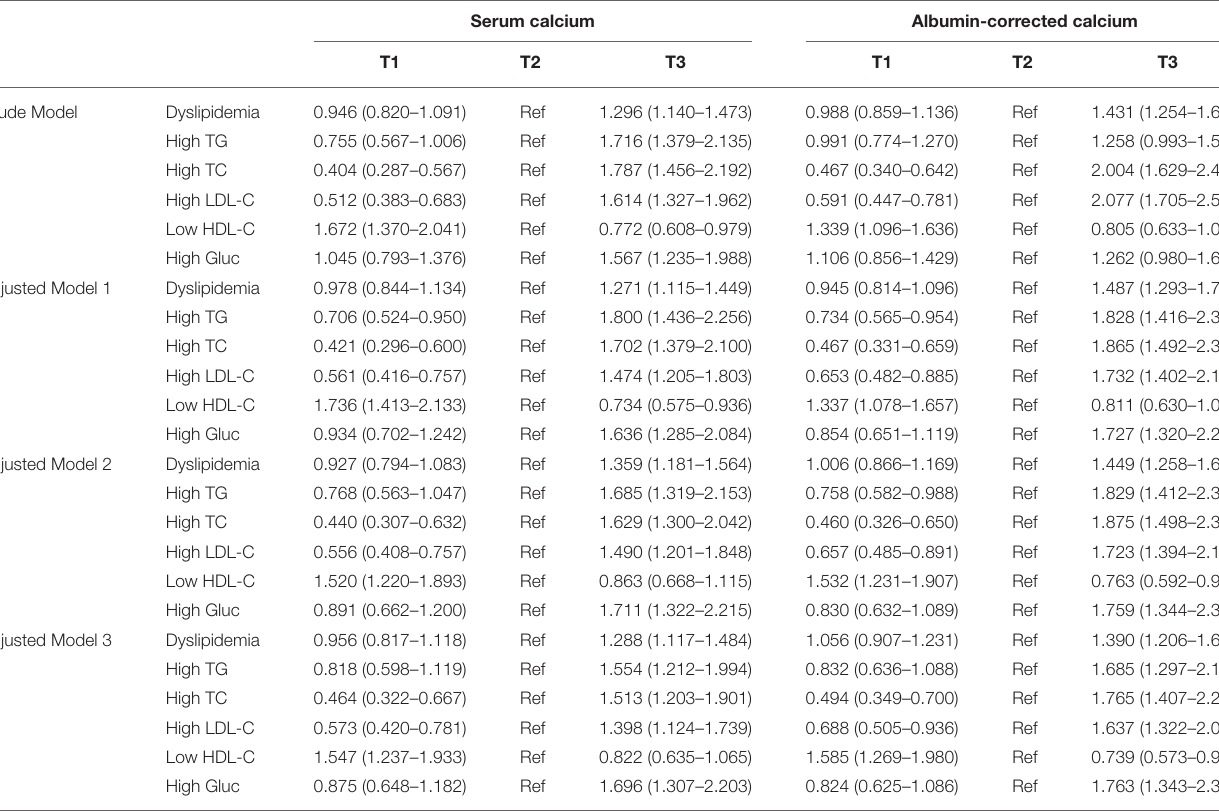
TABLE 4 | Multivariable-adjusted odds ratios and 95% confidence intervals of serum calcium and albumin corrected calcium associated with dyslipidemia. Serum